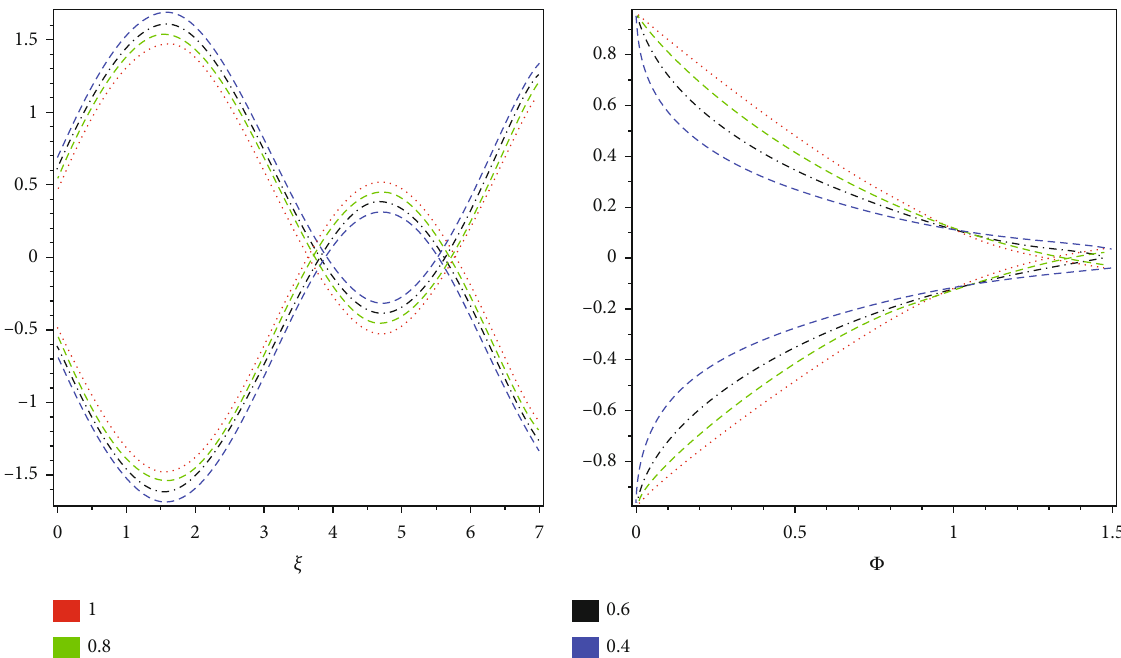
Figure 5: First two-dimensional fuzzy upper branch graph and second bottom branch graph of an analytic series result of various fractional of ρ with respect to time.